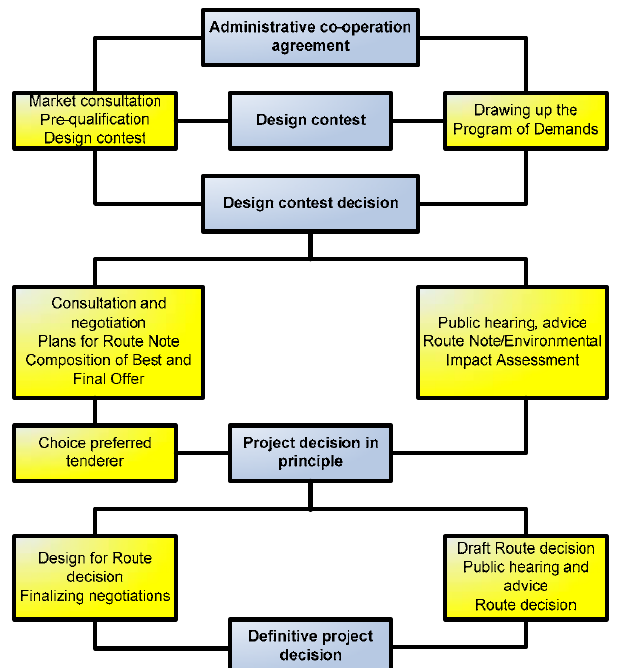
5 Contracting Model for the TP PT